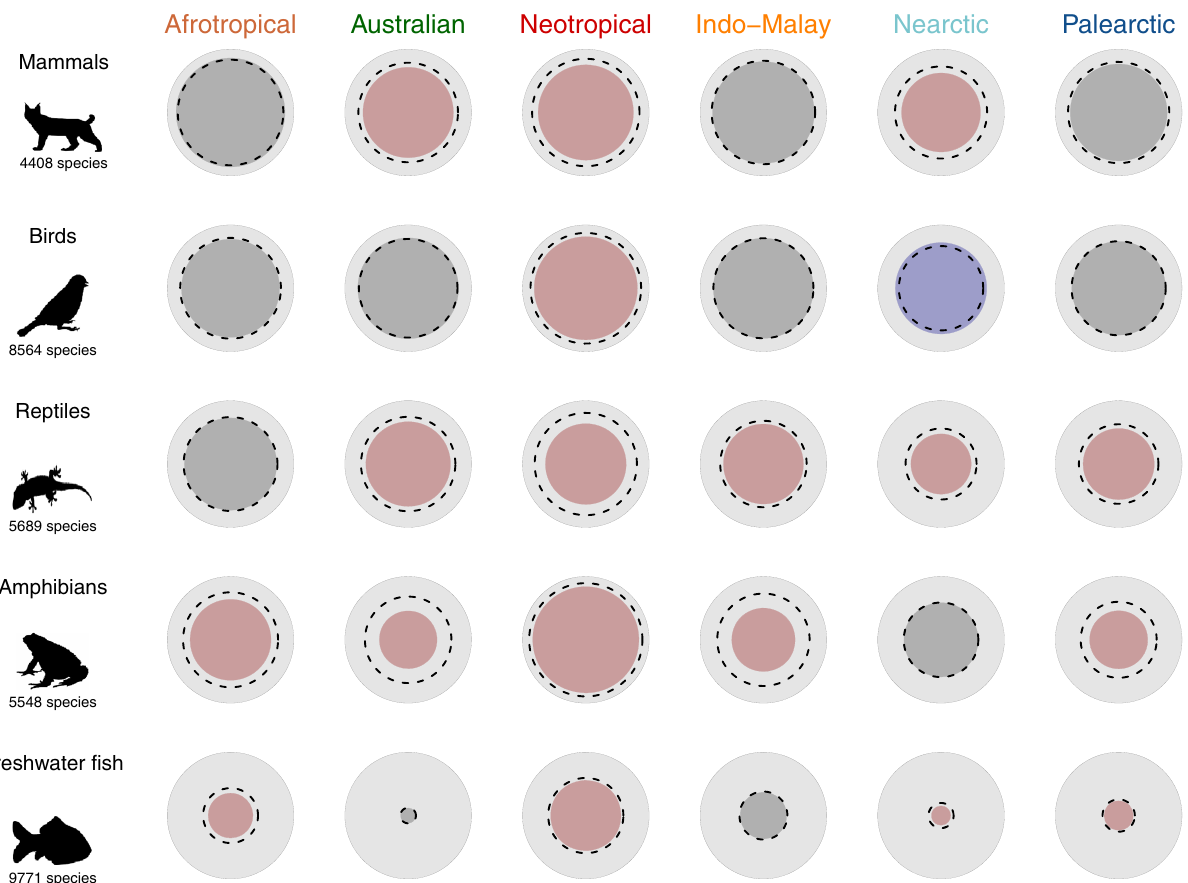
Fig. 2 Functional richness of vertebrates in the six biogeographic realms. For each taxonomic group, the background light grey circle represents the world ’ s functional richness (i.e. considering all species of the group). The inner coloured circle represents the proportion of the world ’ s functional richness hosted by each realm. The dotted line represents the mean expected functional richness calculated with a null model where the same number of species were randomly selected from the world ’ s pool of species (see details in the ‘ Methods ’ ). The colour of the inner circle shows whether the functional richness was signi fi cantly higher (blue), lower (red) or not signi fi cantly different (grey) than a random expectation. Silhouettes were downloaded from PhyloPic (www.phylopic.org). Figures have been made using R (codes are available online, see ‘ Code availability ’ ). Source data are provided as a Source data fi